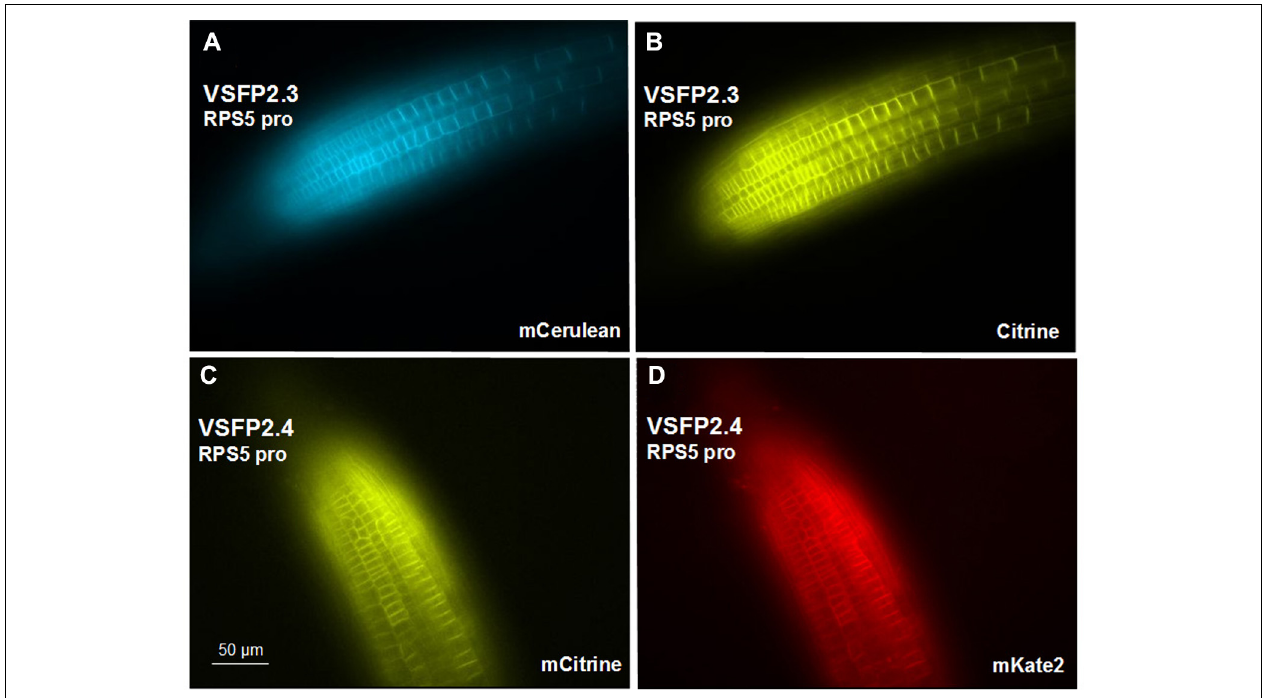
two fluorescent proteins of each FRET pair in this region of the root. In both cases, plants are homozygous for the respectiveVSFP2-encoding construct. Images shown are fluorescence wide field images acquired after focusing on the top cell layers of the root. Excitation (ex) and emission (em) wavelengths (in nm) of the filter cubes used for this image: mCerulean (ex 436/em 480 nm); citrine (ex 500/em 535 nm); mKate (ex 560/em 645